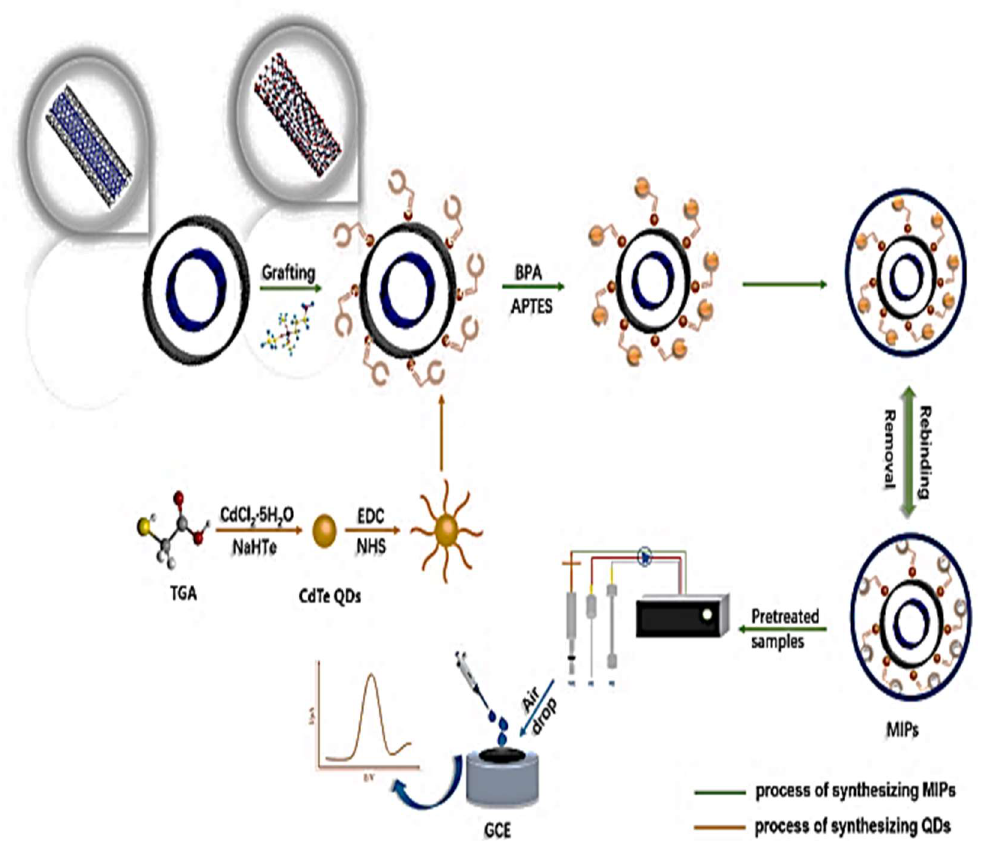
Figure 9. Scheme of the preparation process of BPA electrochemical sensor based on glassy carbon electrode (GCE) and used a mixture of carbon diimide (EDC) and succinimide (NHS) in the preparation of cadmium telluride carboxylate [135]. (Reproduced under permission from Elsevier, doi:10.1016/j.microc.2021.106737).